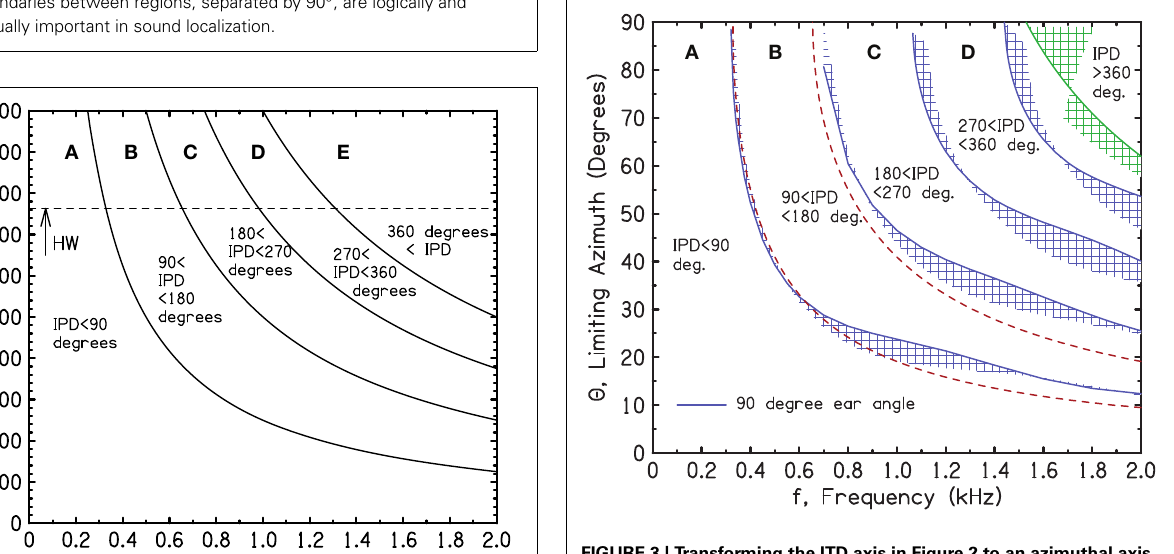
FIGURE 3 | Transforming the ITD axis in Figure 2 to an azimuthal axis using the spherical head diffraction model. The blue shaded regions are bounded by ear angles of 90 ◦ (solid blue line) and 110 ◦ . The green shaded region similarly shows the Woodworth model. The red dashed curves show the low-frequency limit of the spherical head model for IPDs of 90 ◦ and 180 ◦